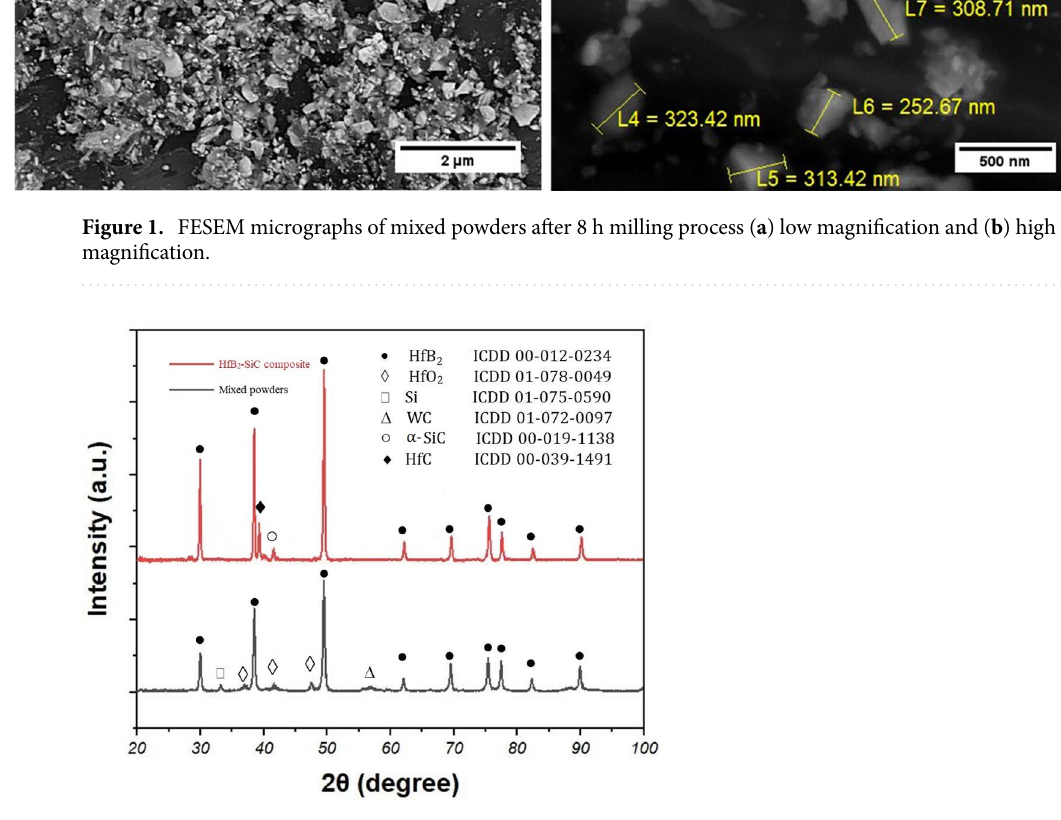
Figure 2. XRD patterns of mixed powders after 8 h milling process and HS20 after the sintering process for 4 h at 2050